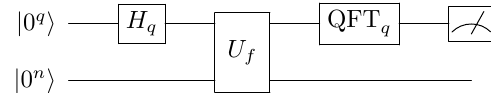
with its hashed